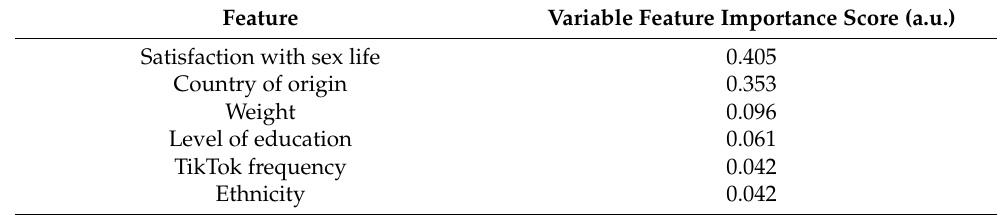
Table 2. CART analysis of factors that influenced happiness with one’s own buttocks. Feature Variable Feature Importance Score